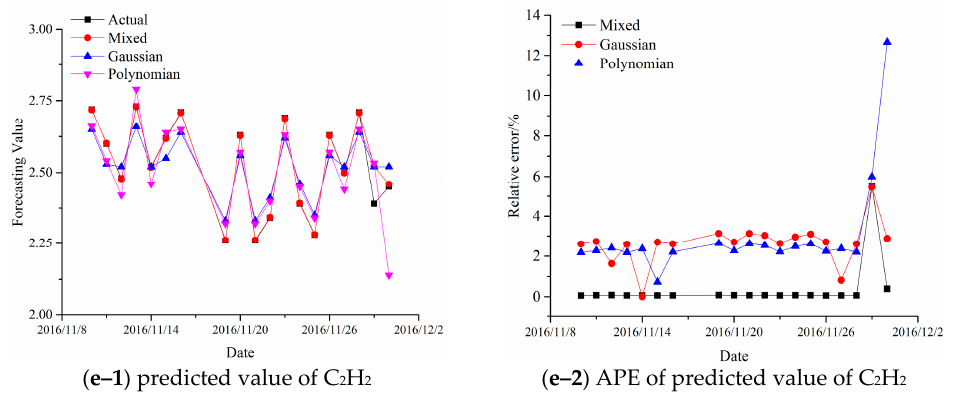
Figure 7. Forecasting value and APE of SVR model with different kernels (Case 2). Table 6. The comparison of the forecasting result (testing set).